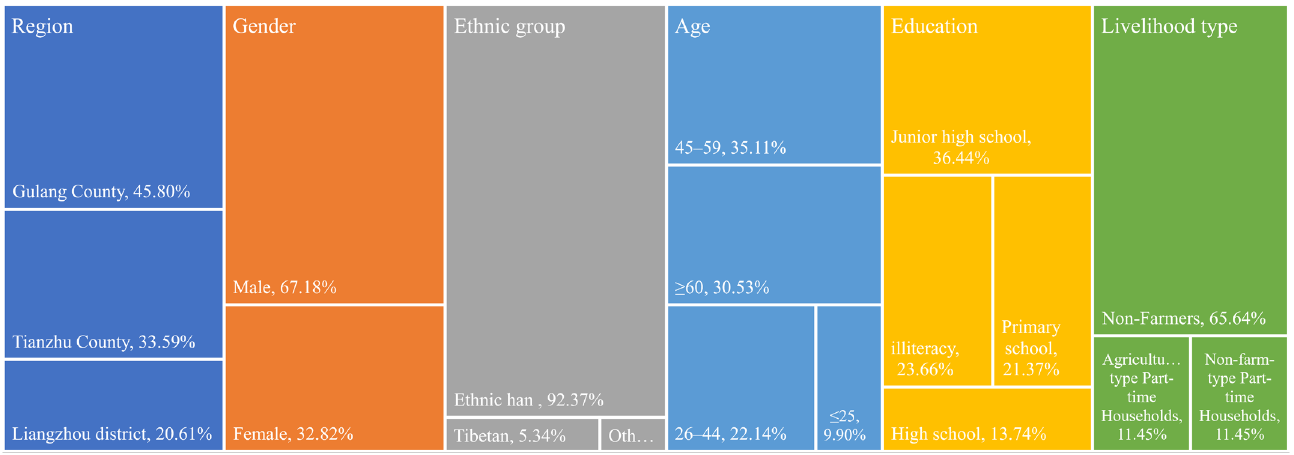
Figure 2. Characteristics of surveyed respondents.